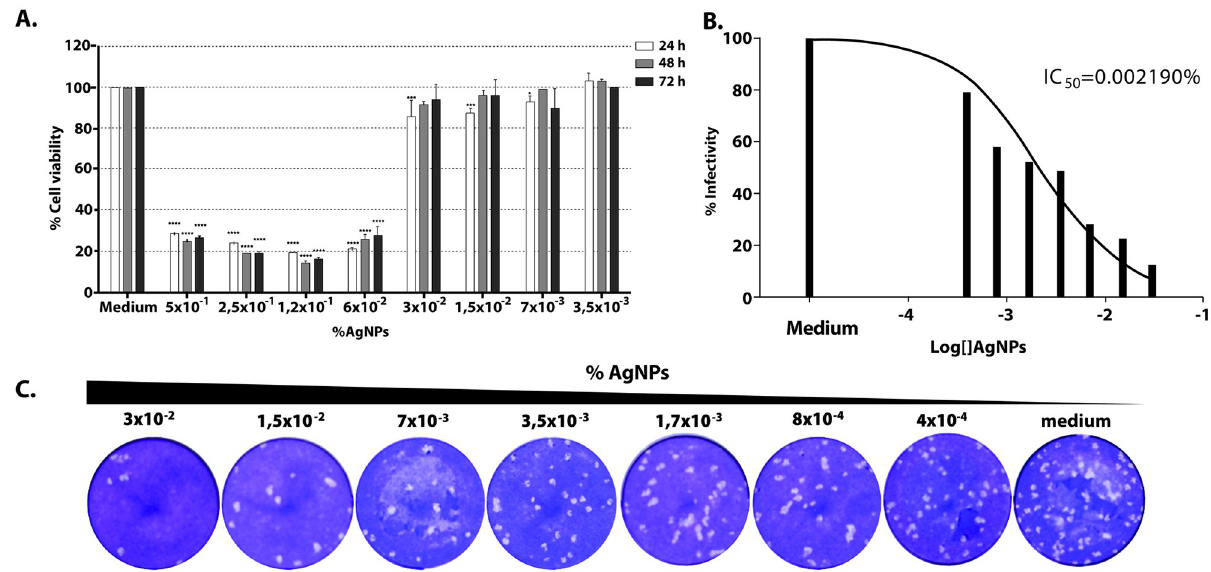
Fig 1. Antiviral activity of AgNPs in Vero E6 cell cultures. A . Effect of AgNPs on viability of cultured Vero cells. Serial two-fold dilutions of AgNPs were added in triplicate to the medium of Vero cells seeded in 96-well plates. Viability at 24 (white bars), 48 (grey bars) and 72 h (black bars) was checked by the MTS Cell Proliferation Assay (Promega) and calculated as described in Methods. Statistically significant differences when compared to the corresponding 100% of cell viability (by 2 way ANOVA) are indicated. � , p < 0.05; ��� , p < 0.001; ���� , p < 0.0001. B . Percentages of infectivity values for each AgNPs concentration. The values were normalized to those in the absence of AgNPs (medium, 100%) and fitted using a non-linear regression algorithm. IC 50 : 50% inhibitory concentration. C . Representative SARS-CoV-2 plaque formation in presence of different dilutions of AgNPs.